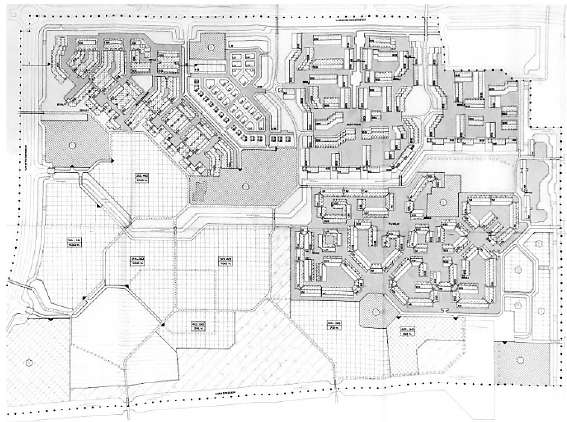
Figure 18. Botter and Tjalk’s urban layout. Source: Flevolands